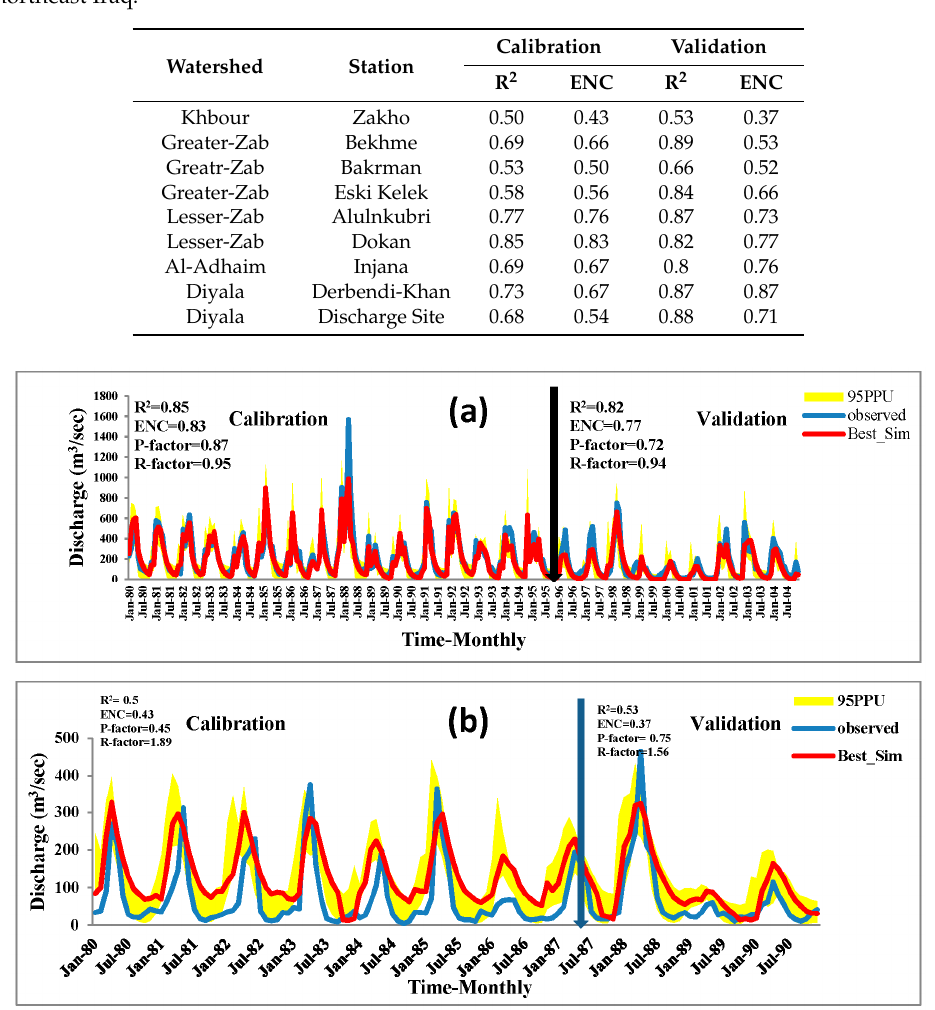
Figure 4. ( a ) Calibration and validation of the SWAT model at monthly scale at Dokan station in Lesser Zab. The dark thick vertical line separates the calibration period in the left from the validation period in the right. ( b ) Calibration and validation of the SWAT model at monthly scale at Zakho Station in Khbour Basin.